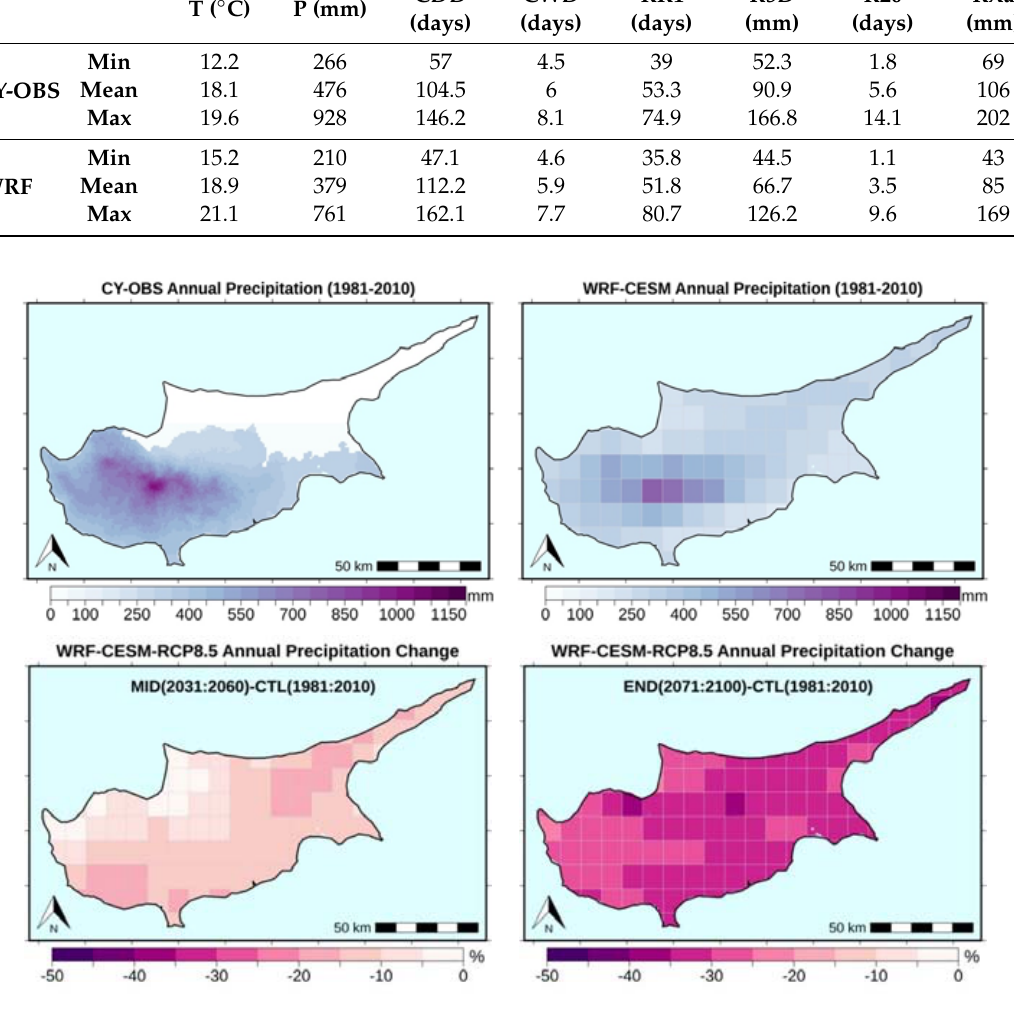
Figure 3. Simulated annual precipitation (grey), 5 ‐ year moving average (black), 30 ‐ year averages (colored), and median and range of 26 EURO ‐ CORDEX simulations (error bars), over Cyprus. The observed average annual temperature climatology according to CY ‐ OBS is presented in the top left panel of Figure 4. The spatial pattern of temperature follows the topography of Cyprus, with higher temperatures (up to 20 ° C) observed in the low ‐ elevation coastal and inland parts of the island and lower annual temperatures (12 ° C) in the high ‐ elevation regions of Troodos. Mean temperature averaged over the historical period of our simulation is presented in the top right panel of Figure 4 and is summarized in Table 2. The spatial gradient is very similar to the observations; nevertheless, the